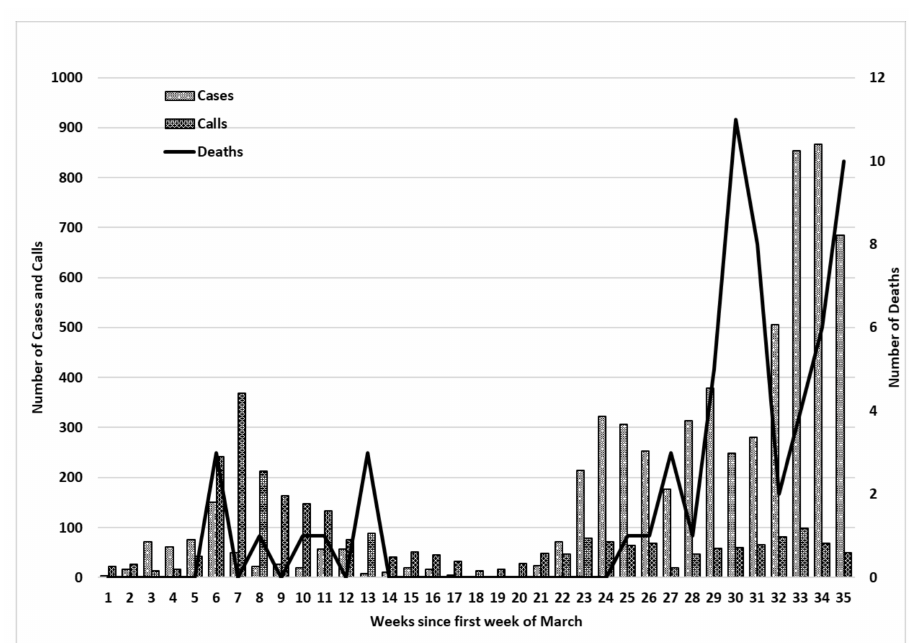
Figure 1. Number of calls to a helpline, cases and deaths over a 35 week period. N.B.: Data collected from daily publication of data by the European Centre for Disease Prevention and